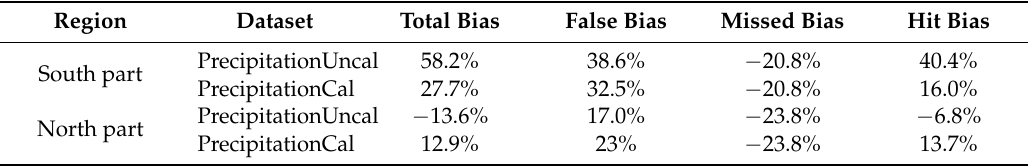
Figure 5. The spatial pattern of the decomposed bias of un-calibrated IMERG and calibrated IMERG. ( a ) the false bias of un-calibrated IMERG; ( b ) the false bias of calibrated IMERG; ( c ) the missed bias of un-calibrated IMERG; ( d ) the missed bias of calibrated IMERG; ( e ) the hit bias of un-calibrated IMERG; ( f ) the hit bias of calibrated IMERG. Table 1. Averaged error components of IMERG before and after calibration (termed as precipitationUncal and precipitationCal) as percentages of total precipitation measured by rain gauges for north and south parts of mainland